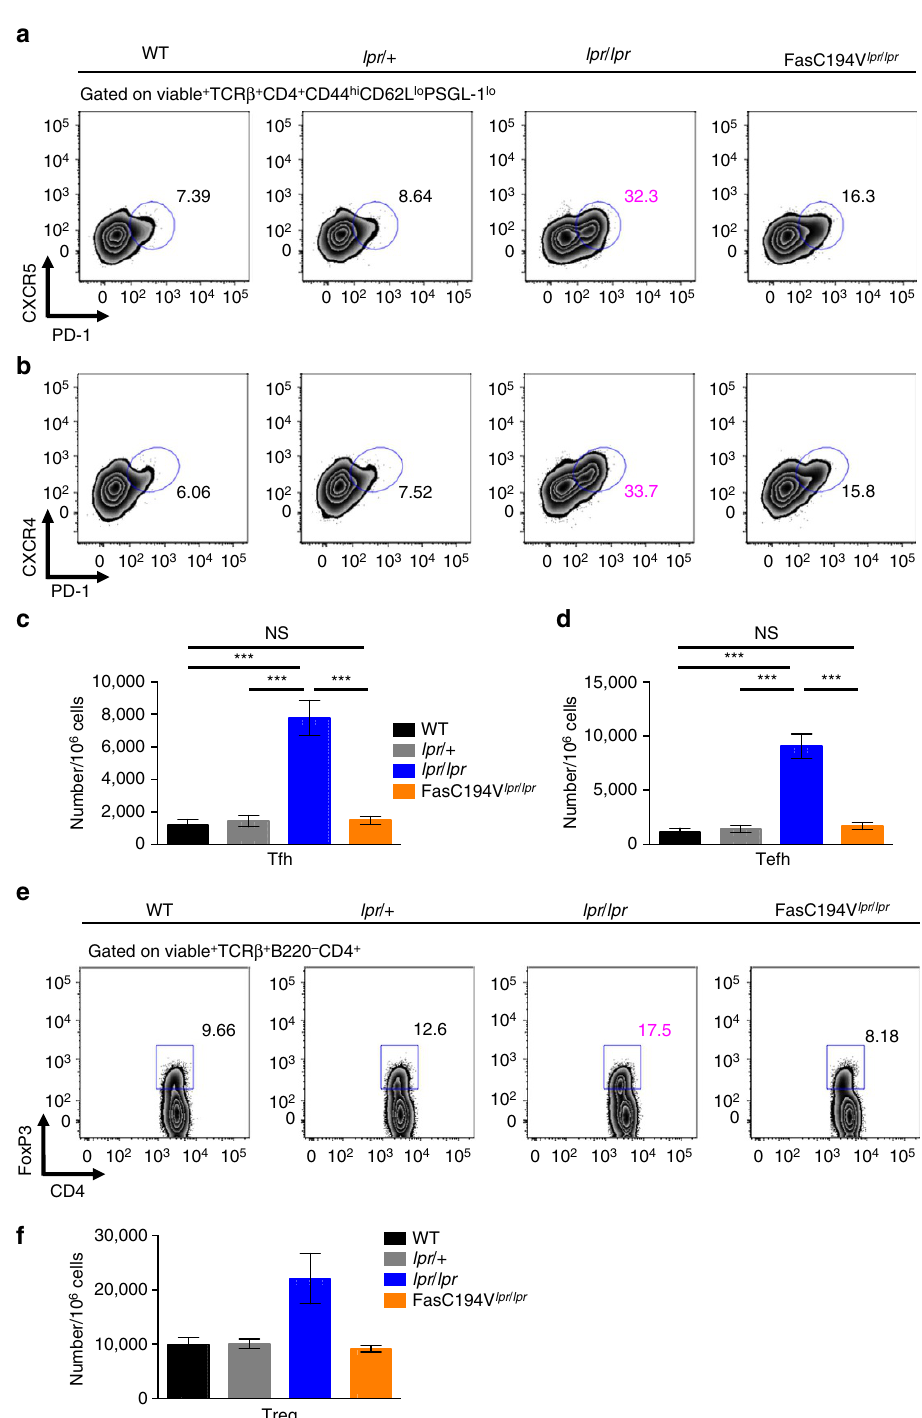
Figure 6 | Fas C194V prevents accumulation of T FH and T EFH . Spleens from 30-week-old WT, lpr/ þ , lpr/lpr and FasC194V lpr/lpr mice were isolated and stained for surface markers to CD4 þ T follicular (T FH ; ( a )) and T extrafollicular (T EFH ; ( b )) cells and analysed by flow cytometry. All cells were gated TCR b þ B220 (cid:2) CD4 þ CD44 hi CD62L lo PSGL-1 lo in the viable cell pool before analysis. Data are representative of six independent experiments ( N ¼ 6). Quantitation for both splenic T FH ( c ) and T EFH ( d ) performed with statistical analysis using Mann–Whitney test. Data are cumulative of 6 independent experiments ( N ¼ 6) ± s.e.m. *** P r 0.001. NS ¼ Not significant. ( e ) Splenocytes from 24-week-old mice of the indicated genotypes were stained for markers to Tregulatory cells. All cells were gated TCR b þ B220 (cid:2) CD4 þ in the viable cell pool before analysis. Data are representative of three independent experiments ( N ¼ 3), with quantitation performed in f showing data as mean ±